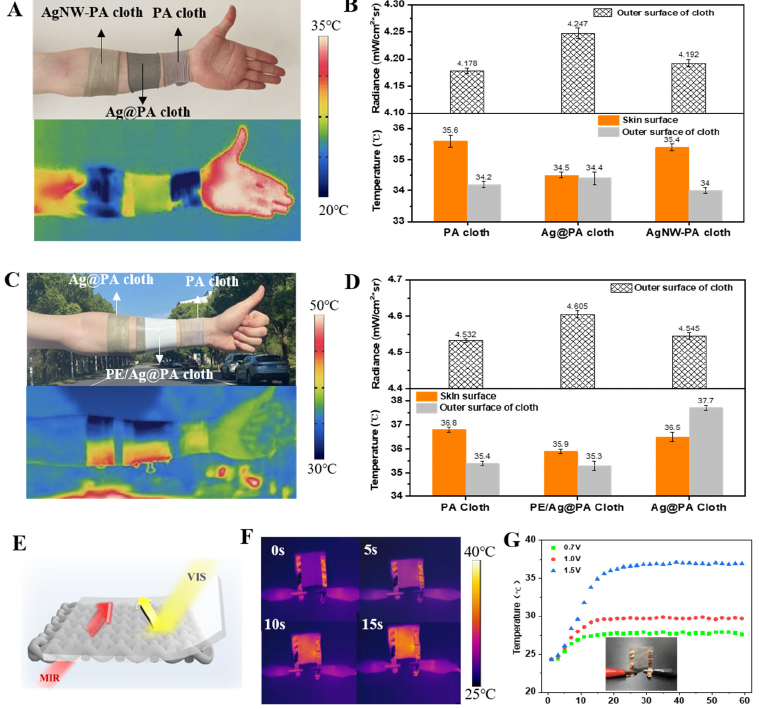
Figure 4. ( A ) Optical and IR thermal images of three kinds of fabrics wrapped around forearm in indoor and ( B ) their radiant energies, surface temperatures comparison; ( C ) optical and IR thermal images of three kinds of fabrics wrapped around forearm outdoor and ( D ) their radiant energy, surface temperatures comparison; ( E ) schematic diagram for the passive cooling of PE/Ag@PA cloth in hot environment; ( F ) IR photos of Ag@PA fiber bundle at 0, 5, 10, and 15 s after applying 1.5 V voltage; ( G ) the temperature change versus time after applying different voltages to Ag@PA cloth.